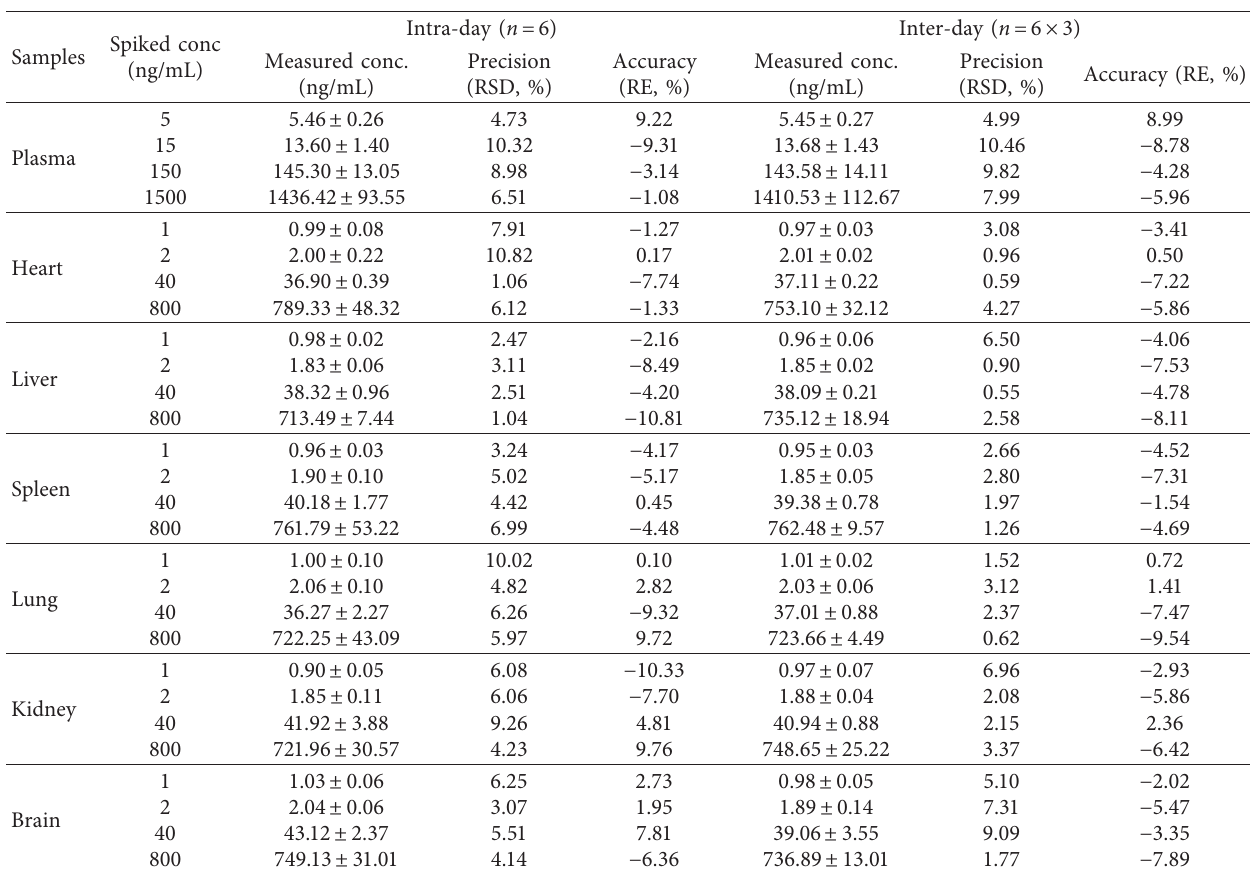
Table 2: Precision and accuracy of the approach to Schisandrol B measurement in biological samples ( n � 6). Spiked conc Samples (ng/mL)